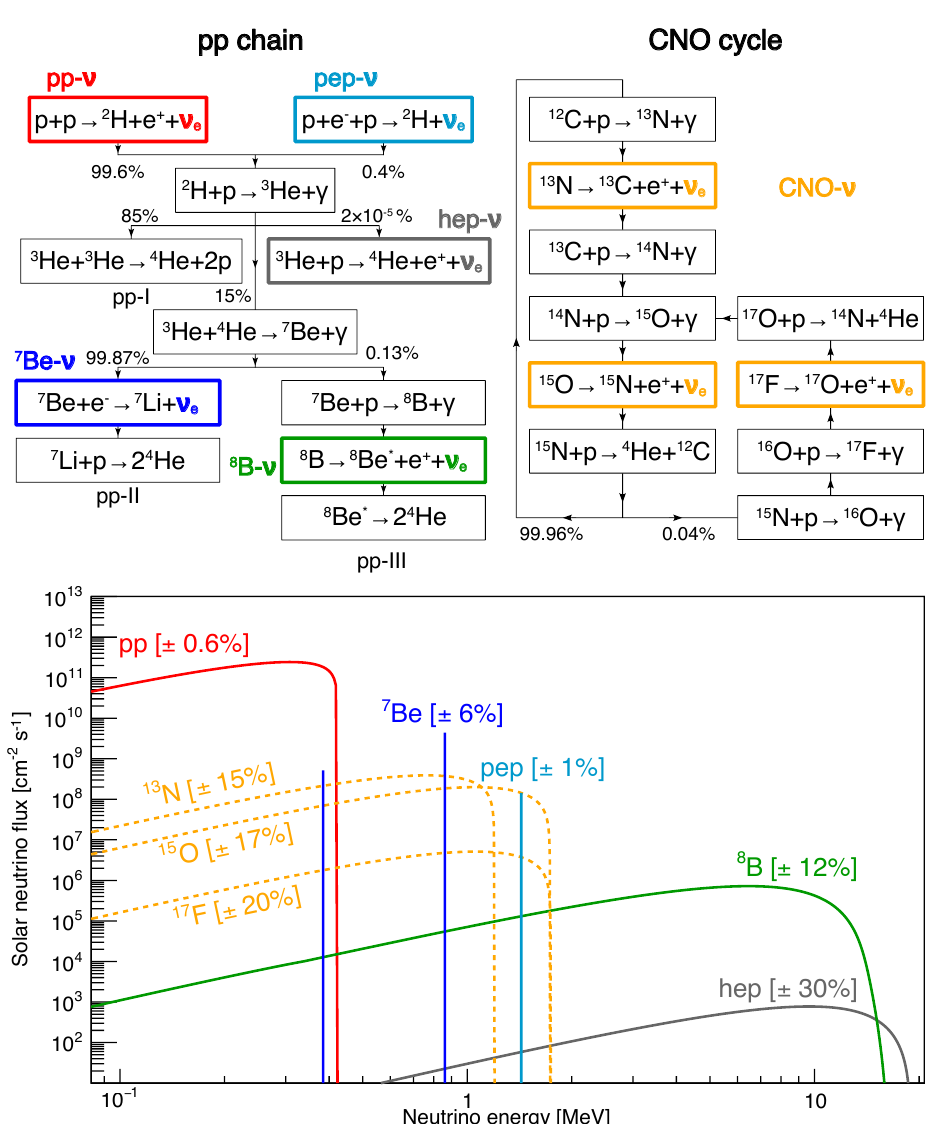
Figure 4. Top: Schematic view of the pp (left) and CNO (right) nuclear fusion sequences. Bottom: The solar neutrino energy spectra obtained from http://www.sns.ias.edu/~jnb/ (accessed on 26 May 2021), using the updated fluxes taken from [54]. The flux (vertical scale) is given in units of cm − 2 s − 1 MeV − 1 for continuum sources and in cm − 2 s − 1 for mono-energetic sources. The numbers in brackets represent the relative flux uncertainties for HZ-SSM prediction as quoted in Table 3 after constraining the solar luminosity as presented in